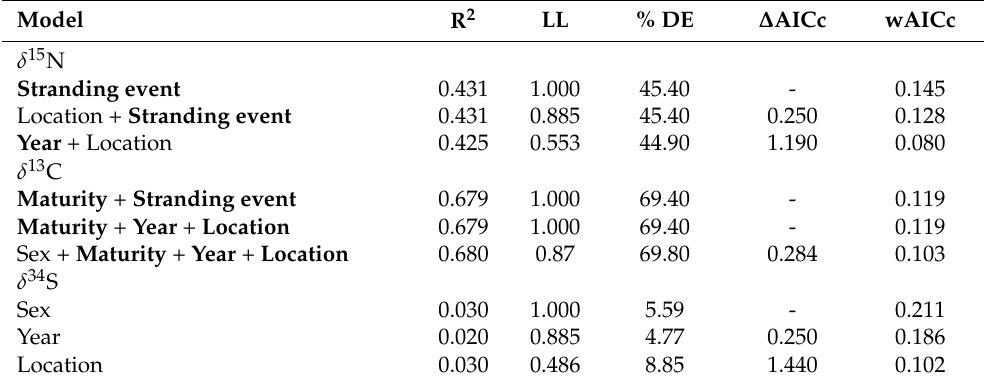
Table 4. Summary statistics for the top three generalised additive models (GAMs) selected based on Akaike Information Criterion corrected for small samples sizes (AICc) of long-finned pilot whale ( Globicephala melas edwardii ) skin samples, presented by carbon, nitrogen and sulphur ( δ 15 N, δ 13 C and δ 34 S) values. LL: log-likelihood; % DE: % deviance explained; ∆ AICc: difference in Akaike’s information criterion (AIC C ) of the current and top-ranked model; wAICc = AIC C weight. Significant variables are highlighted in bold.